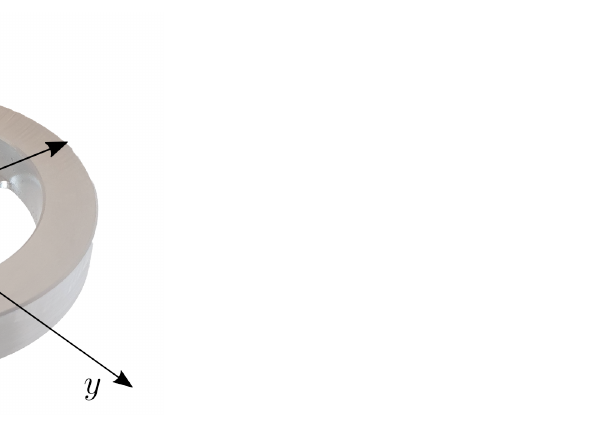
Figure 7. The final design of the flywheel, shown together with its principal axes of inertia. Here, h is the wheel thickness, r is the inner radius of the wheel and R is the radius of the outer one. Table 1. Sizes and dynamic parameters of a single